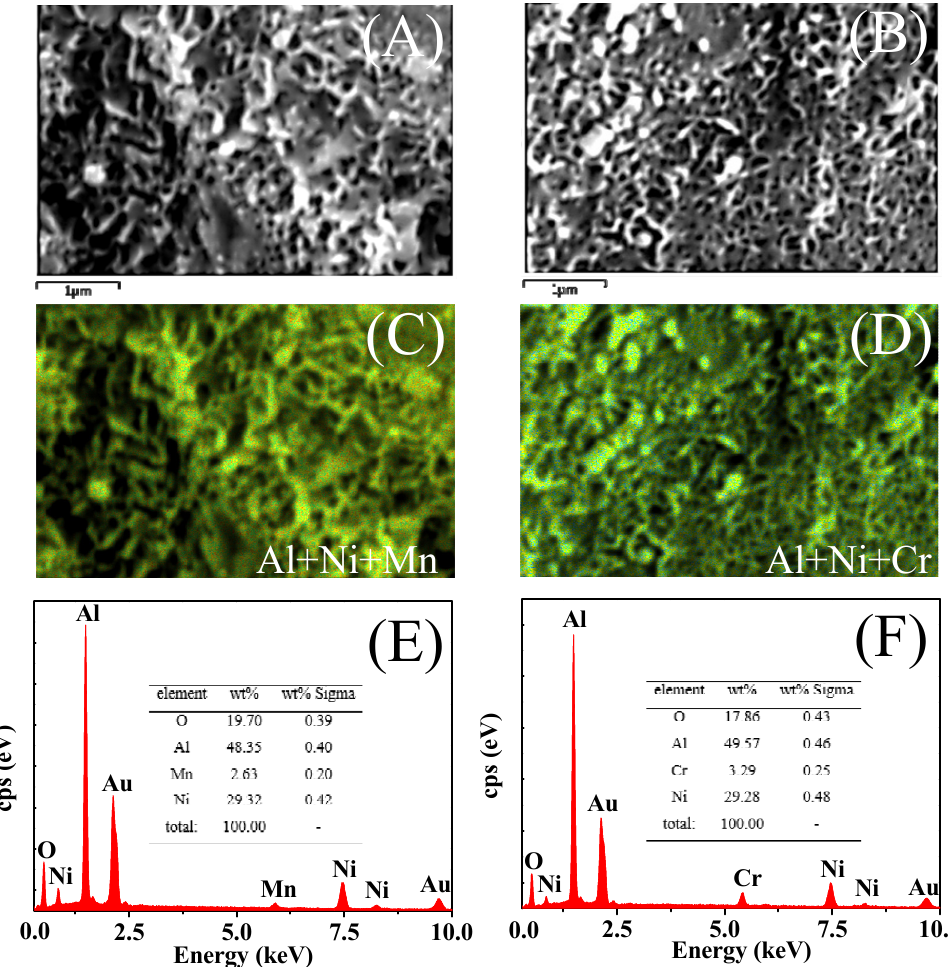
Figure 11. SEM images ( A , B ), corresponding total elemental mapping images ( C , D ) and EDS (energy dispersive spectroscopy) analysis ( E , F ) of reduced catalysts. ((A,C,E) for 15Ni ‐ 3Mn and (B,D,F) for 15Ni ‐ 3Cr).